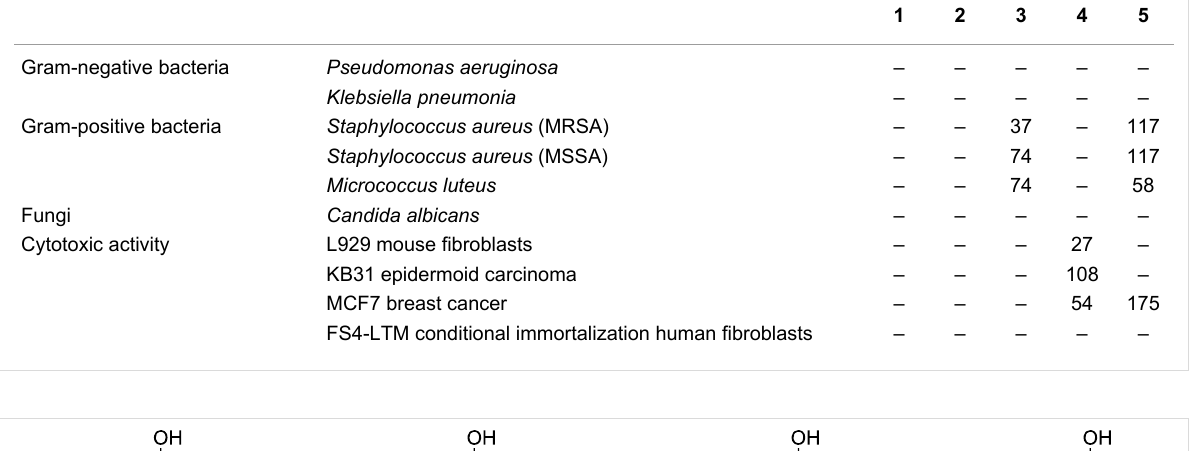
Table 4: Results of the antimicrobial and antiproliferation assays of compounds 1 – 5 . Minimum inhibiting concentrations (MIC) for the antimicrobial assays and the IC 50 values for the antiproliferation assays are given in µM.